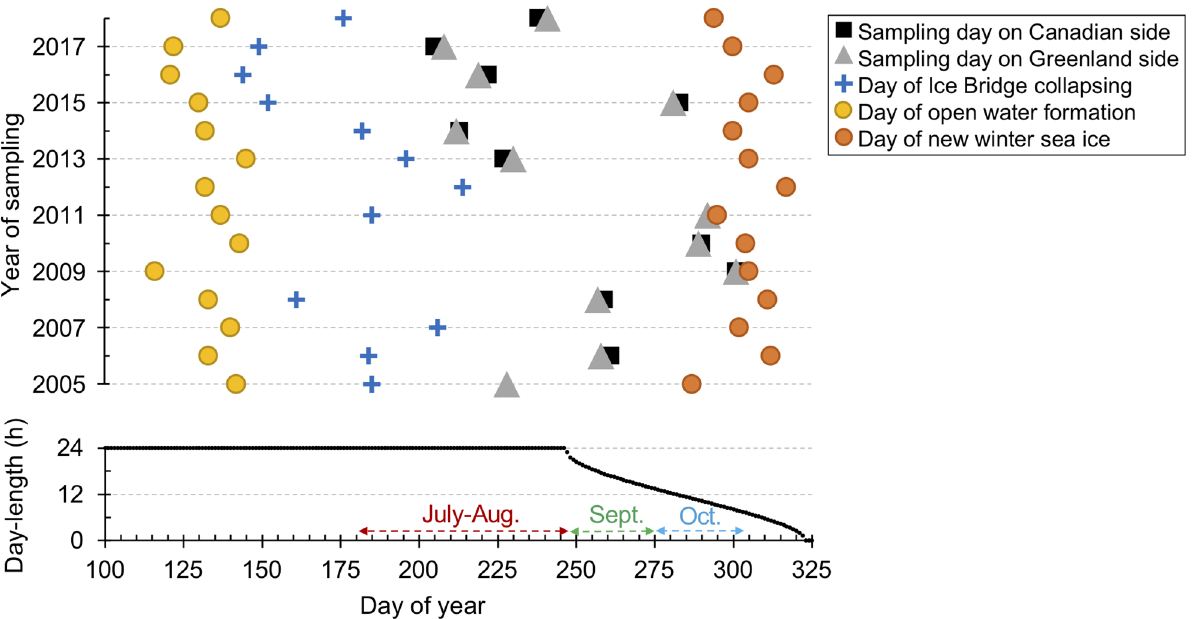
Figure 2. Key events by day of year (Julian date). Upper panel shows dates of selected conditions from 2005 to 2018: the first day of open water forming the polynya (yellow circles) in the North Water; date of the Nares Strait ice bridge collapsing (blue crosses); sampling dates (black squares for Canadian side sampling, grey triangles for the Greenland side) and the date of new winter sea-ice (orange circles) that corresponds to the date when sea-ice covers Nares Strait to the north, and an indication of onset of winter ice conditions (see Supplementary Table S1). The panel below indicates the day-length based on latitude 76.36°N and longitude − 74.01°W over the same time